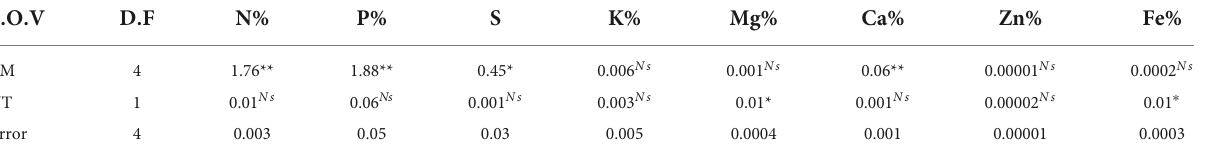
TABLE 5 Treatment and variety effects on teff grain nutrients